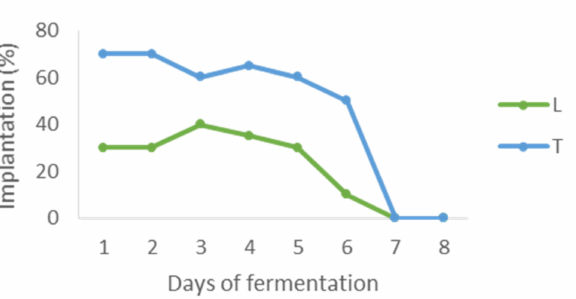
Figure 2. Presence of the yeasts of the mixed inoculum LT1 during the fermentation (L: Lachancea thermotolerans , T: Torulaspora delbrueckii